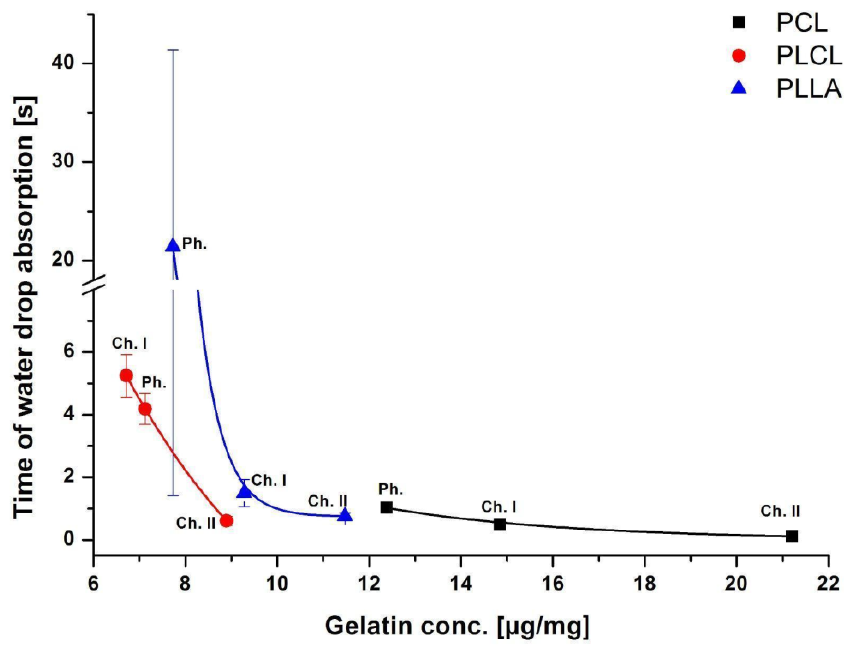
Figure 5. Time of waterdrop absorption as a function of gelatin concentration for physically (Ph.) chemically (Ch. I; Ch. II) modified